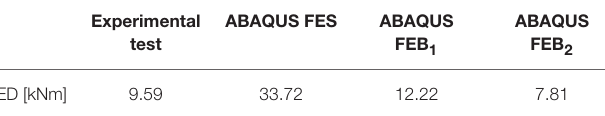
TABLE 1 | Total energy dissipated for experimental test and numerical models referring to